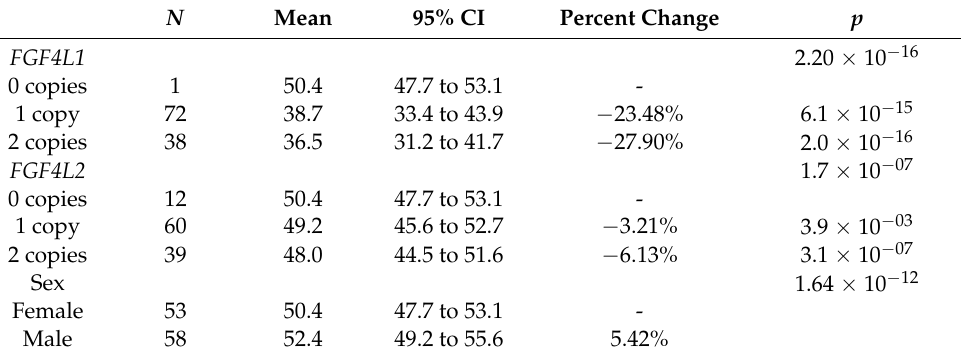
Figure 1. Height at the shoulder is shown for each genotype class for 36 Schweizer Niederlaufhund and 111 Alpine Dachsbracke dogs. The bars represent the mean and standard deviation for each genotype class. Some genotype classes did not have any dogs identified. The shaded areas show the allowed shoulder height according to breed standard for each breed. Genotype classes are ordered the same for both breeds and by descending means. Table 1. Multivariable analysis of height in cm at the shoulders in 111 Alpine Dachsbracke